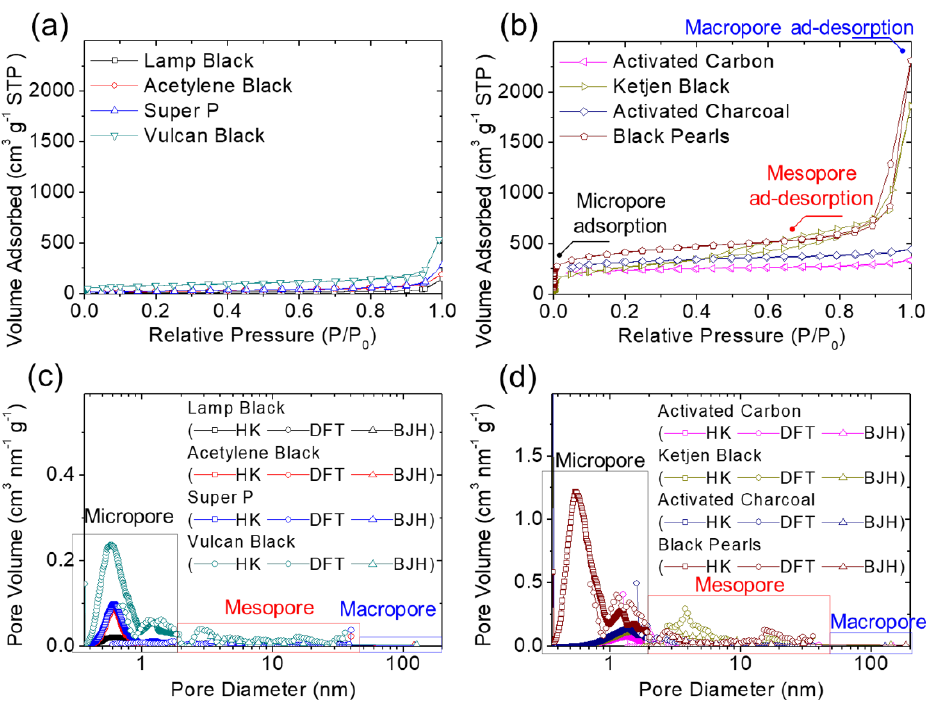
Figure 1. Material characteristics: ( a,b ) nitrogen adsorption/desorption isotherms and ( c,d ) pore-size distributions of various carbon materials for the carbon-coated separators. Table 1. Materials characteristics: porosity analysis of the